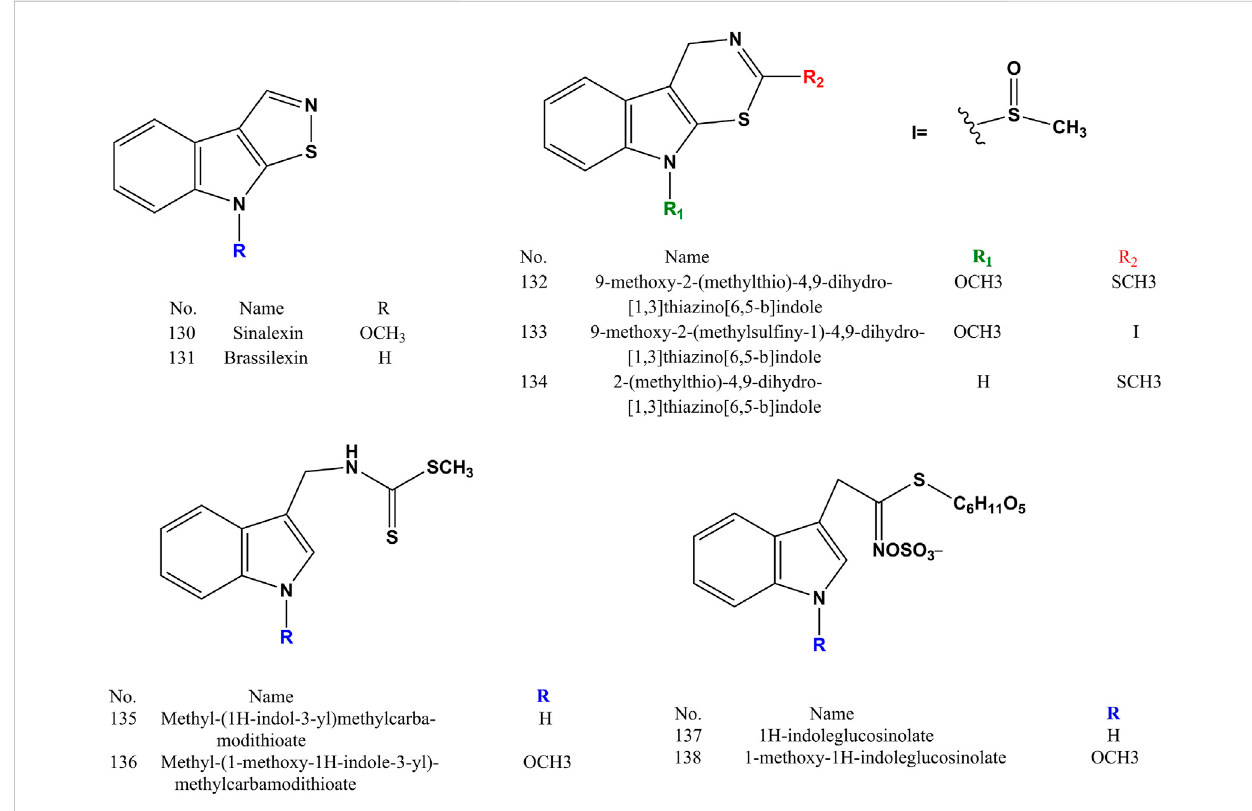
FIGURE 6 Chemical structures of indole derivatives identi fi ed from SS (compound 130 – 138